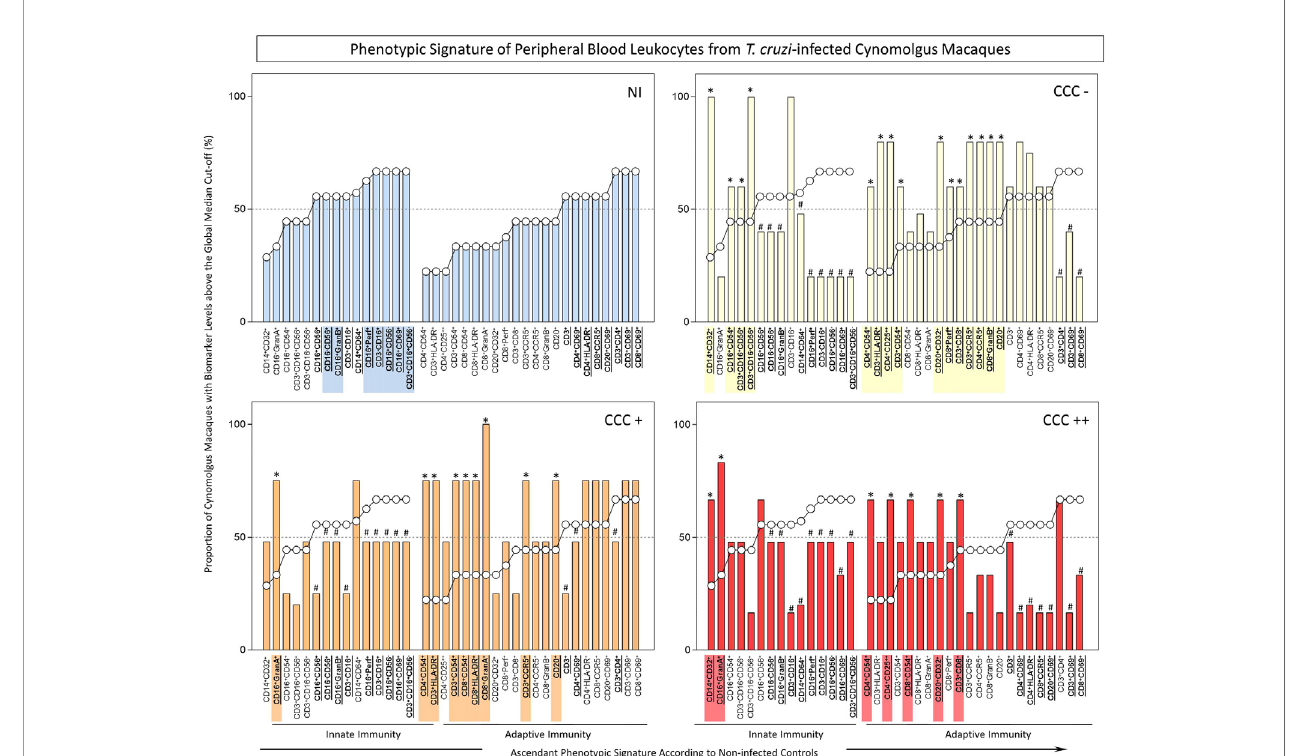
FIGURE 1 | Ex-vivo phenotypic signatures of peripheral blood leukocytes from T. cruzi -infected cynomolgus macaques classi fi ed according to histopathological features of chronic chagasic cardiopathy. The phenotypic signatures were constructed based on the proportion of subjects in each cell subpopulation with biomarker levels above the global median cut-off, calculated from data from the entire study population. Ascendant curves were assembled from non-infected controls (NI) to draw the reference curves for innate and adaptive immunity cells, used for comparative analysis of results from T. cruzi -infected cynomolgus macaques. Data are displayed by bar charts (NI = ) and continuous ascendant lines (NI = ○ ). The T. cruzi -infected macaques were classi fi ed according to histopathological features of cardiac biopsies and referred to as CCC( – ) for absence of chronic chagasic cardiopathy ( ); CCC(+) for mild chronic chagasic cardiopathy ( ) and CCC(++) for moderate chronic chagasic cardiopathy ( ). Comparative analyses between T. cruzi -infected subgroups and non-infected controls were carried out considering the ascendant biomarker signature of non-infected controls as the reference curve. The differences between groups were considered for biomarkers with proportions con fi ned to distinct 50 th percentiles as compared to the reference curve. The biomarkers with lower frequencies in T. cruzi -infected macaques were underscored by # and bold underline format. Those biomarkers with higher frequencies in T. cruzi -infected macaques were highlighted by *, bold underline format and color